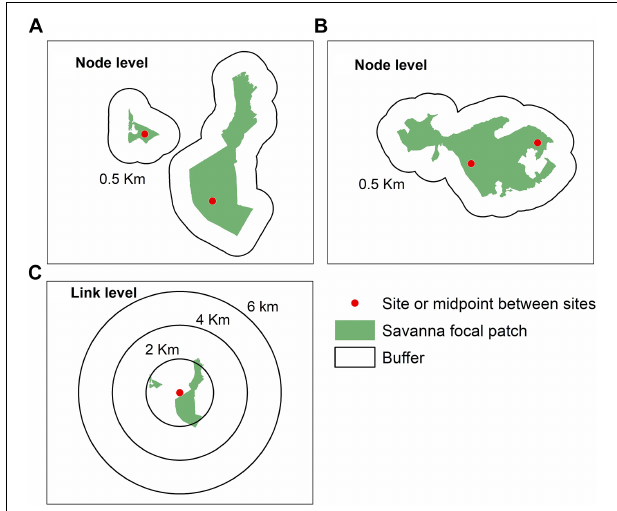
FIGURE 2 | Sampling design to quantify landscape metrics at node and link levels for Tabebuia aurea in the Brazilian Cerrado. (A) Sampling design at node level in landscapes with sites in different patches of savanna. (B) Sampling design at node level in landscapes within the same patch of savanna, which corresponded to protected areas. (C) Sampling design at link level showing the buffers with different radii around the midpoint between the two sampling sites. For details of sampling sites see Figure 1 , and Appendix Table S1